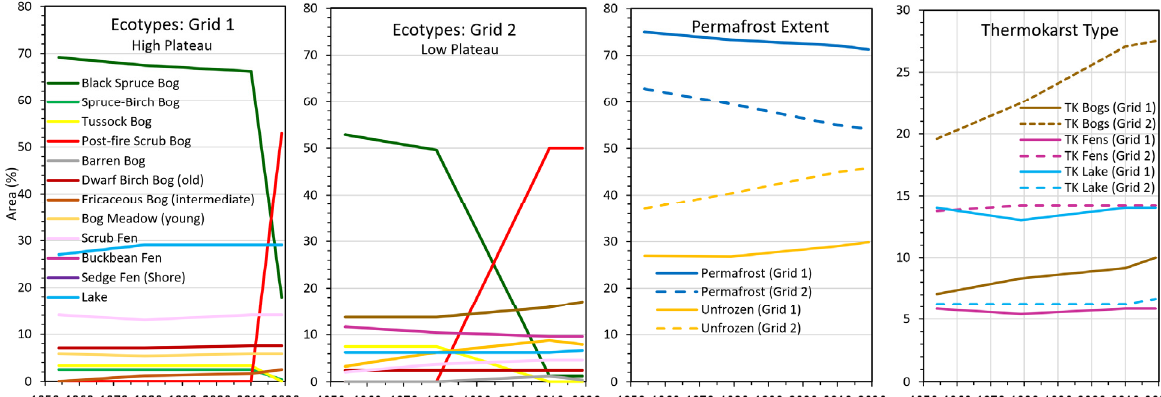
Figure 4. Areal changes (percent of grid points) in ecotypes, permafrost, and thermokarst type on two photo-interpreted grids near Gosling Lake, DNPP, from 1954 to 2019.